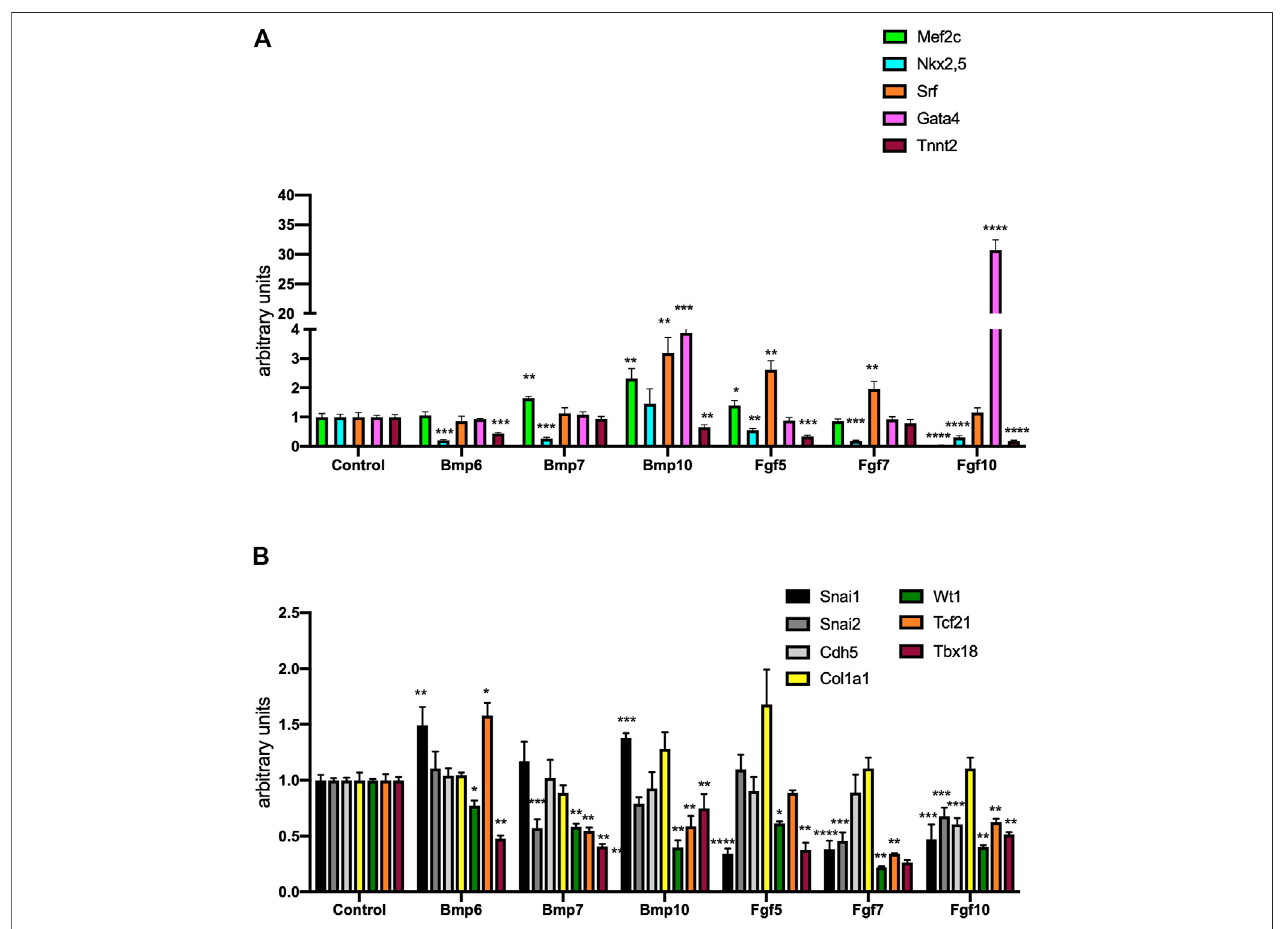
FIGURE6| Panel (A) RT-qPCRanalysesofMef2c,Nkx2.5,Srf,Gata4andTnnt2expressionaftercontrol,Bmp6,Bmp7,Bmp10,Fgf5,Fgf7andFgf10treatments, respectively,tomouseE9.5PE/STexplants.Panel (B) RT-qPCRanalysesofSnai1,Sna2,Cdh5,Col1a1,Wt1,Tcf21andTbx18expressionaftercontrol,Bmp6,Bmp7, Bmp10, Fgf5, Fgf7 and Fgf10 treatments, respectively, to mouse E9.5 PE/ST explants. * p < 0.05, ** p < 0.01, *** p < 0.001, **** p < 0.0001.